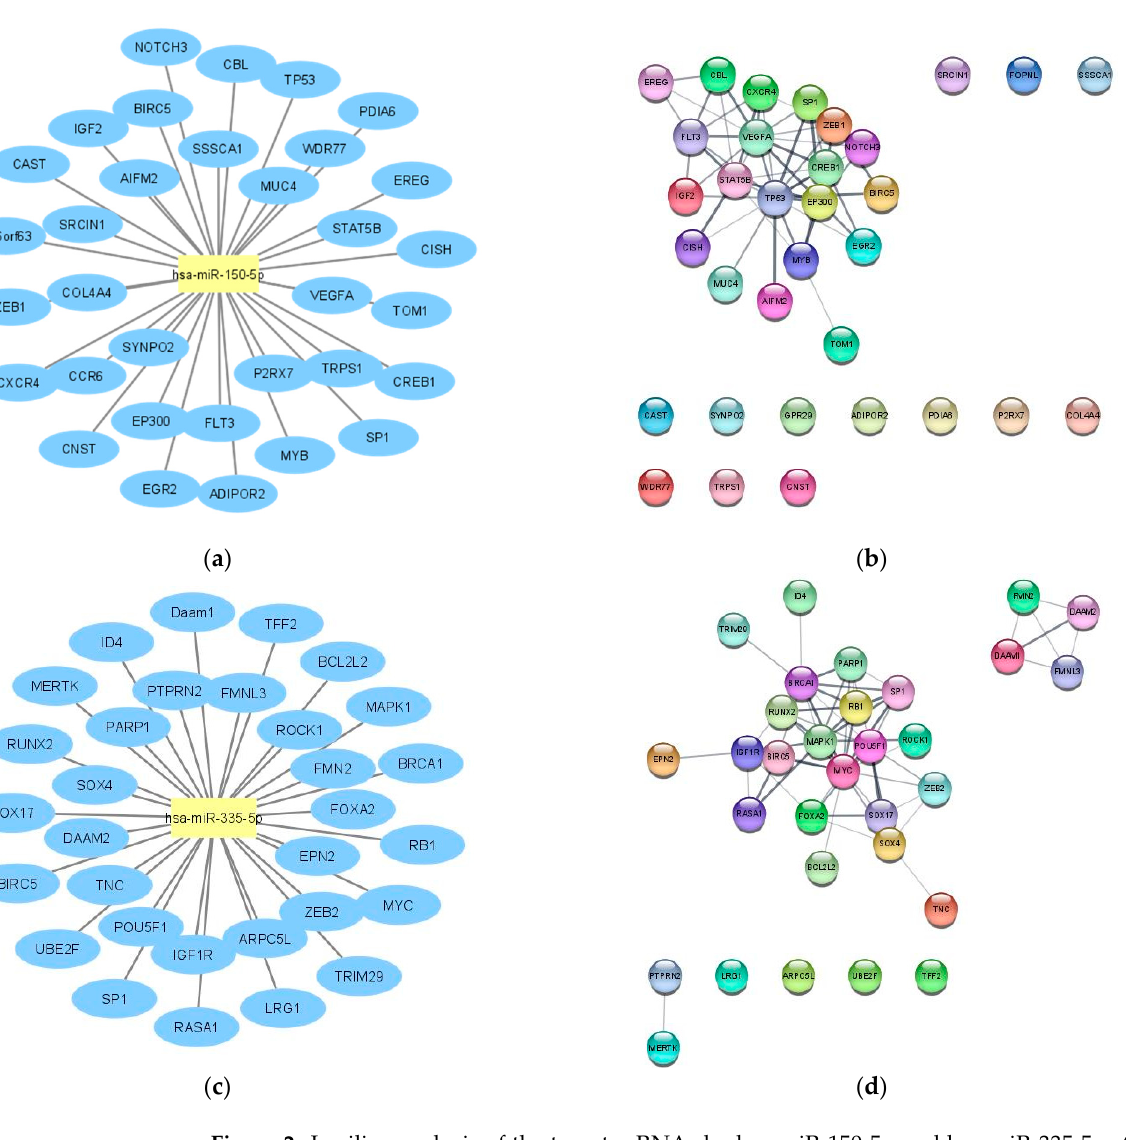
Figure 2. In silico analysis of the target mRNAs by hsa-miR-150-5p and hsa-miR-335-5p. ( a ) hsa- miR-150-5p target mRNAs according to miRTarBase database analysis; ( b ) target mRNAs of hsa- miR-150-5p organized by string interactions clusters; ( c ) hsa-miR-335-5p target mRNAs accord- ing to miRTarBase database analysis; ( d ) target mRNAs of hsa-miR-335-5p organized by string interactions